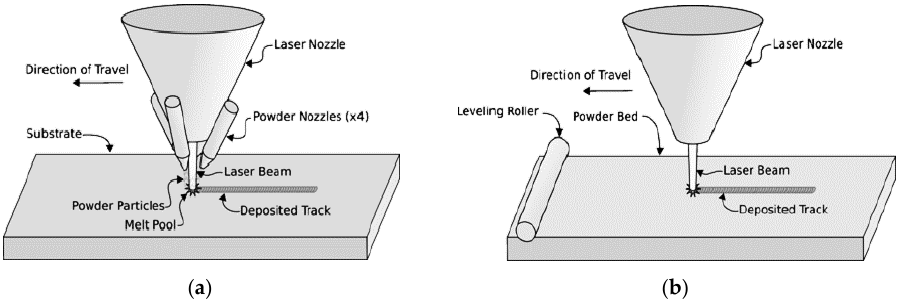
Figure 7. ( a ) Laser Engineered Net Shaping (LENS) and ( b ) Selective Laser Sintering (SLS)